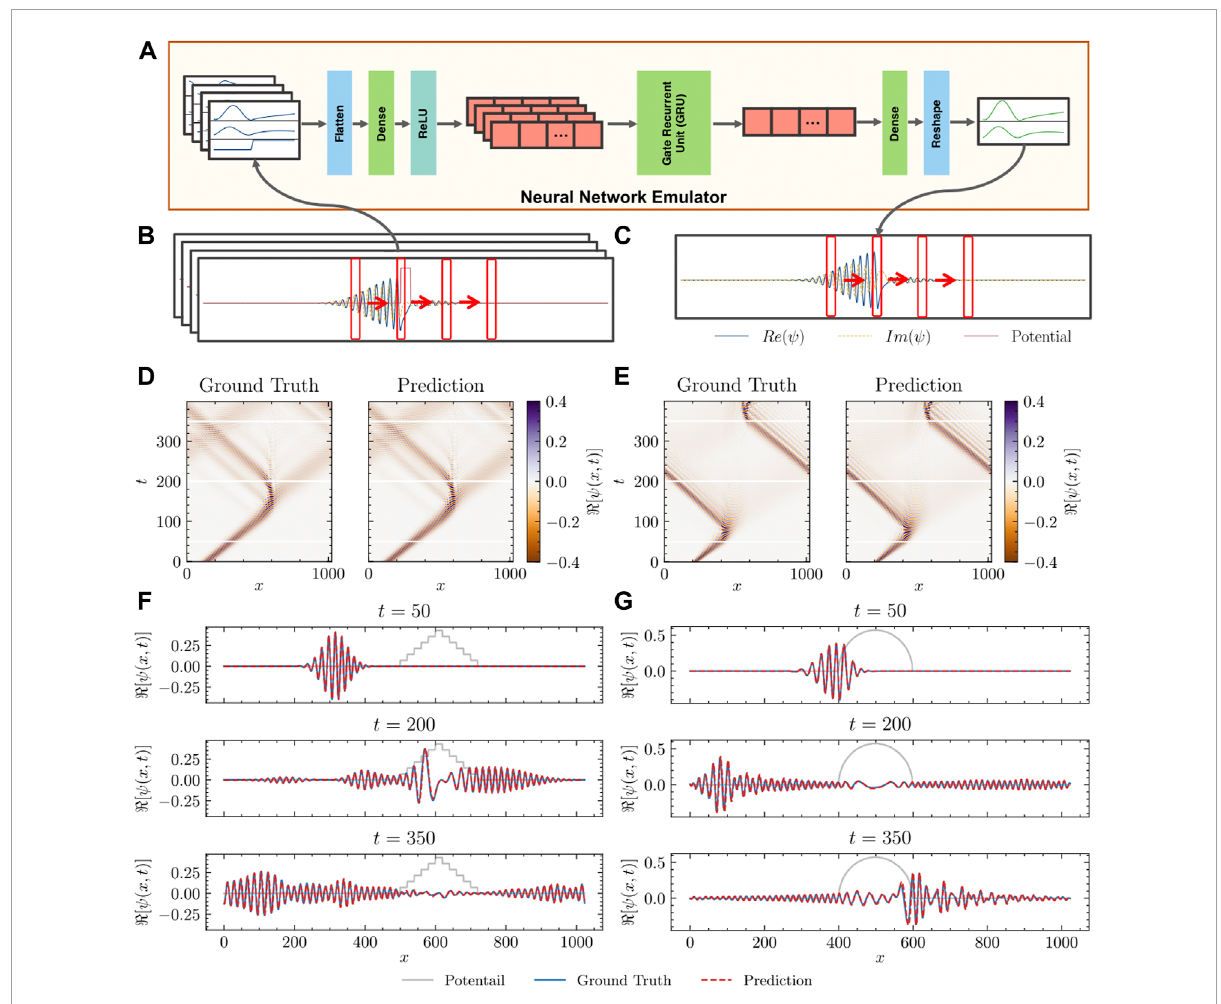
FIGURE 3 Machine Learning-Based Neural Network Emulator. (A) , Proposed neural network emulator architecture, along with the corresponding input and output. The rectangle boxes illustrate different types of neural network layers, and the red arrays represent the hidden states (hidden vectors). (B) , Data representation of an exemplary raw input. The red rectangles represent spatial slices of the data ( windows ). (C) , Data representation of an exemplary output of the neural network emulator. (D) , Ground truth and the predicted value of R [ ψ ( x , t )] for an initial Gaussian wave packet and for a pyramid shaped potential barrier. (F) , Comparisons of the predicted evolution and the ground truth for three temporal snapshots, t ∈{ 50 , 200 , 350 } , depicted by the white horizontal lines in panel (D) . (E,G) , A similar comparison, but for a half-circle shaped potential barrier